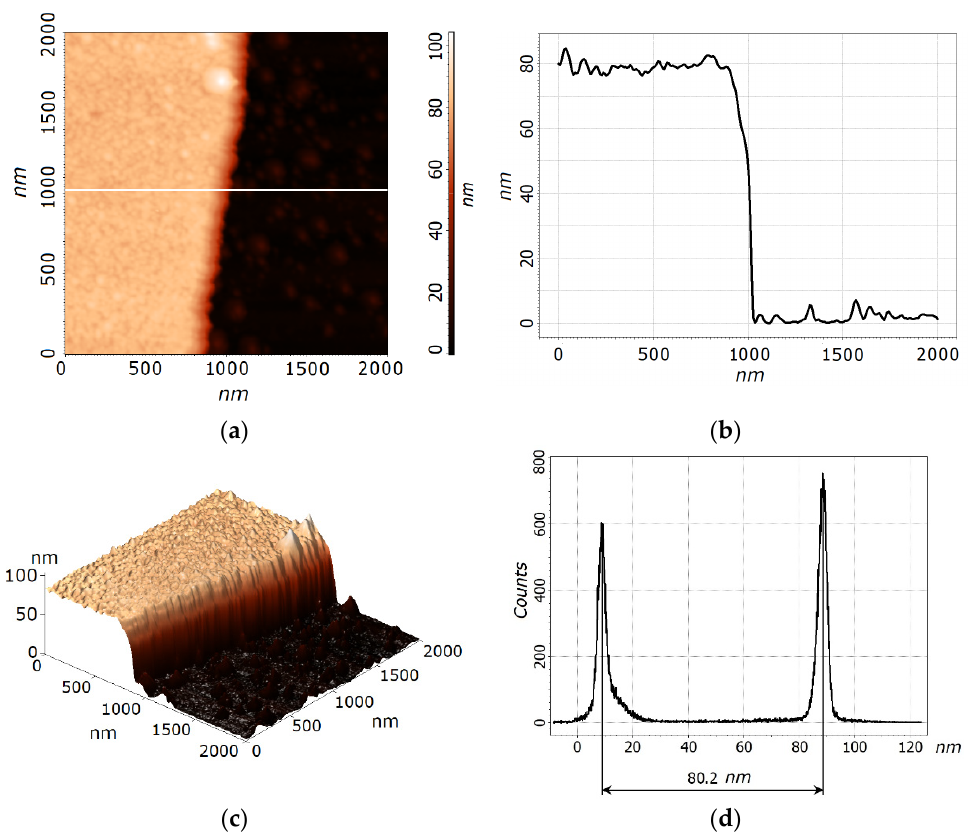
Figure 4. Experimental studies of a structure in a LiNbO 3 film: AFM image ( a ); AFM cross-section ( b ) along the “white” line indicated in ( a ); 3D AFM reconstruction image ( c ); height histogram ( d ).